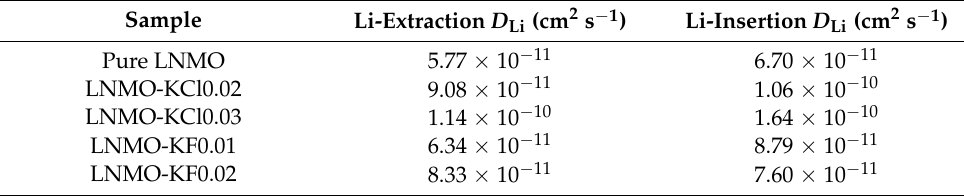
Table 3. The diffusion coefficients of Li + in all